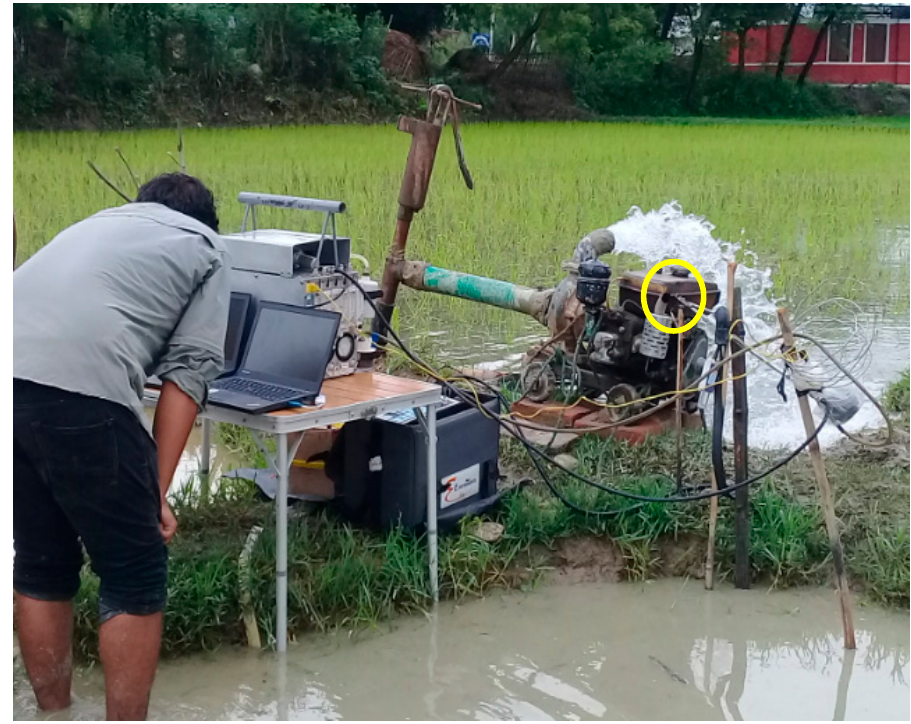
Figure 3. Real-time measurement of pump emissions in a paddy field, Saptari district, Nepal. Yellow circle indicates Ratnoze1 inlet near to the pump exhaust.